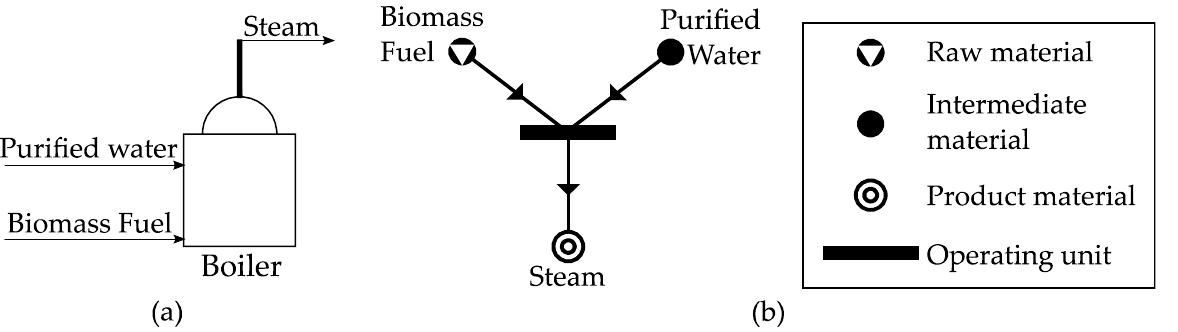
Figure 1. Depiction of a boiler in conventional representation ( a ) and P-graph representation ( b ).